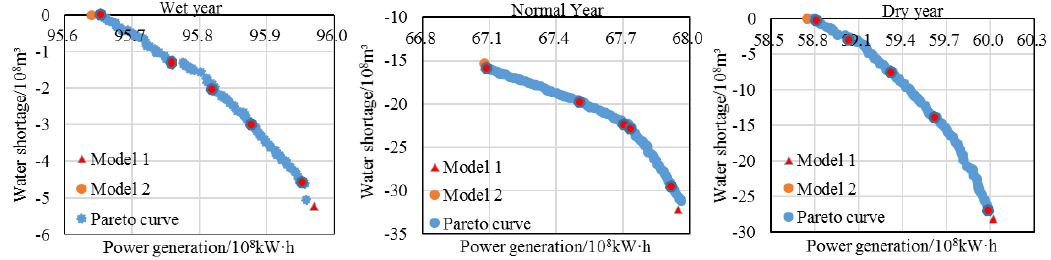
Figure 9. Multi-objective Pareto-front curves in each typical year.